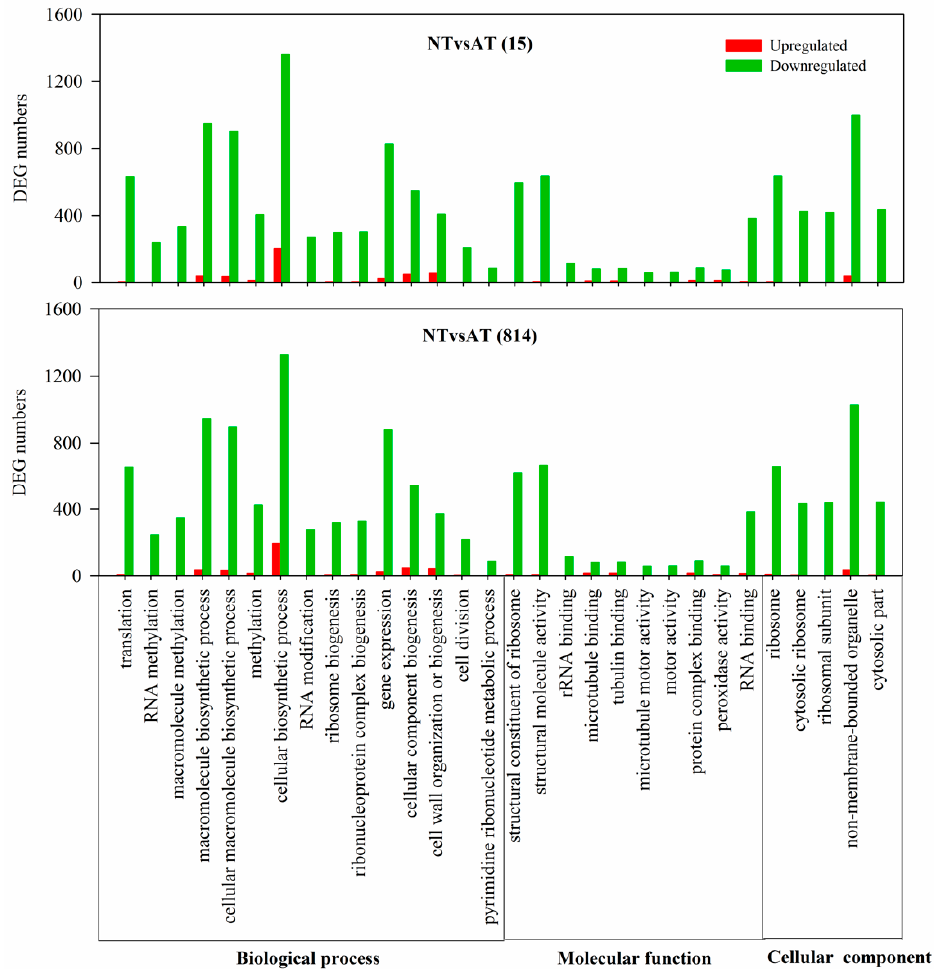
Figure 4. Enriched Gene Ontology (GO) terms for NTvsAT (15 and 814). The results are summarized under three top-level ontologies: biological process, molecular function, and cellular component. The x -axis represents the functional category of the DEGs. The y -axis indicates the number of annotated genes expressed in a given subcategory. The downregulated DEGs are represented by green, and the upregulated DEGs are represented by